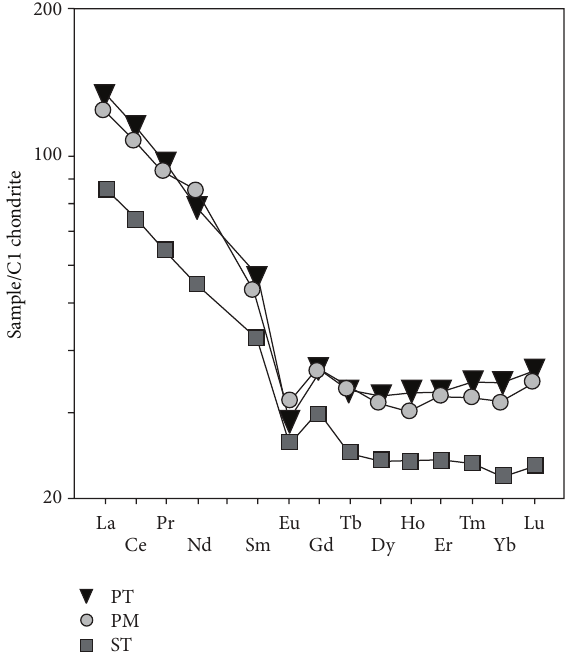
Figure 4: Spider diagram of REE for PT, PM, and ST